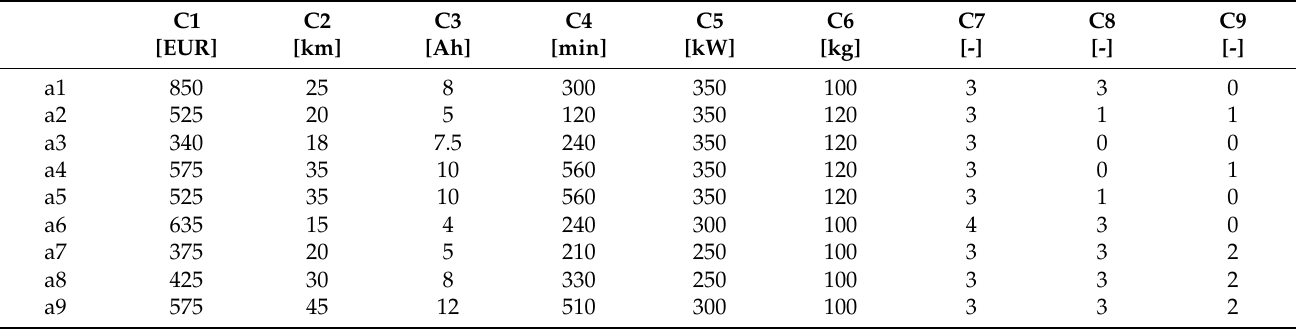
Table 3. Technical data of the vehicles used during the